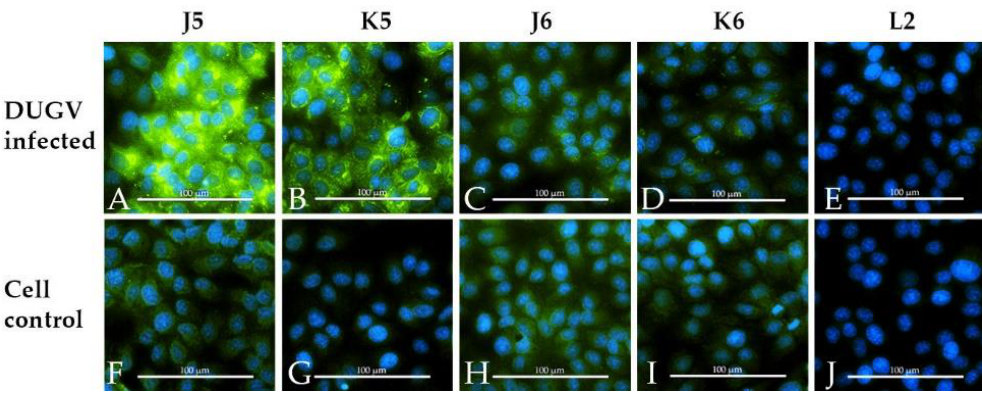
Figure 4. Indirect immunofluorescence assay with Vero E6 cells infected with DUGV ( A – E ) and non-infected control wells ( F – J ). Calf J5 ( A/F ), K5 ( B/G ), J6 ( C/H ) and K6 ( D/I ) show a specific staining of DUGV-infected cells, whereas the serum of the mock control L2 ( E/J ) tested negative.